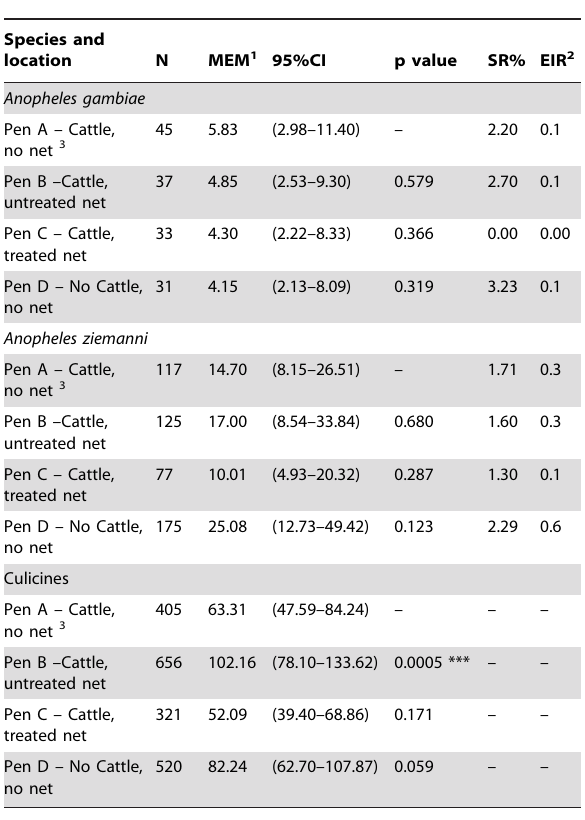
Table 2. Total number of mosquitoes, model estimated means (MEM) and 95% confidence intervals (95% CI) of HLC collections performed 20 m apart from all experimental pens as well as sporozoite rates (SR) and entomological inoculation rates (EIR).